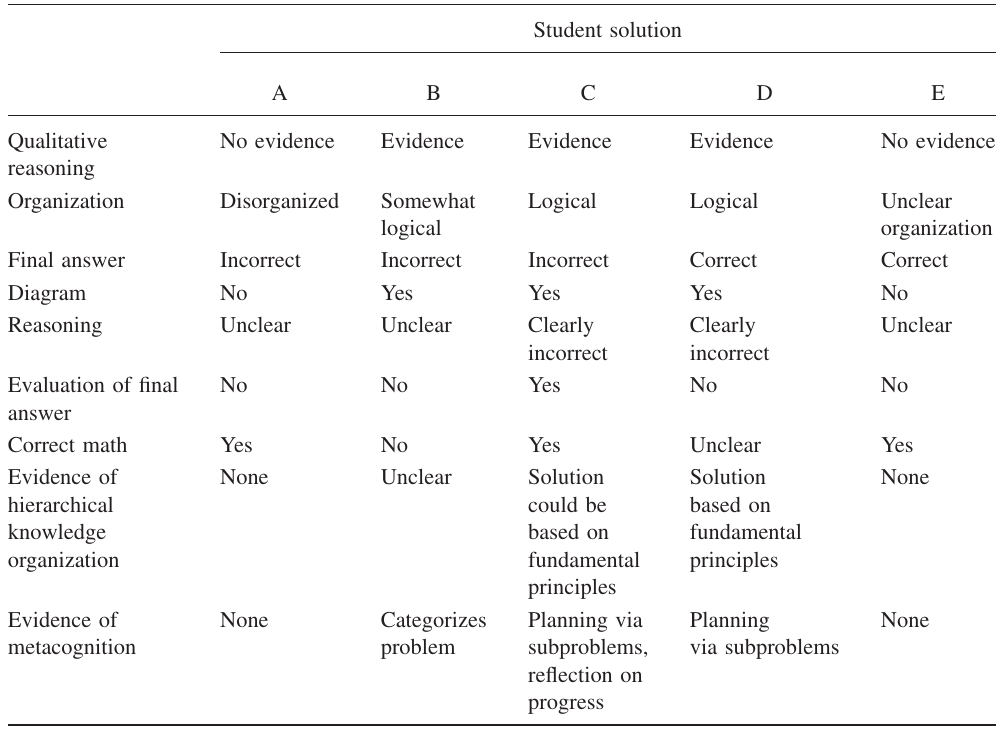
TABLE I. Characteristics of student solution